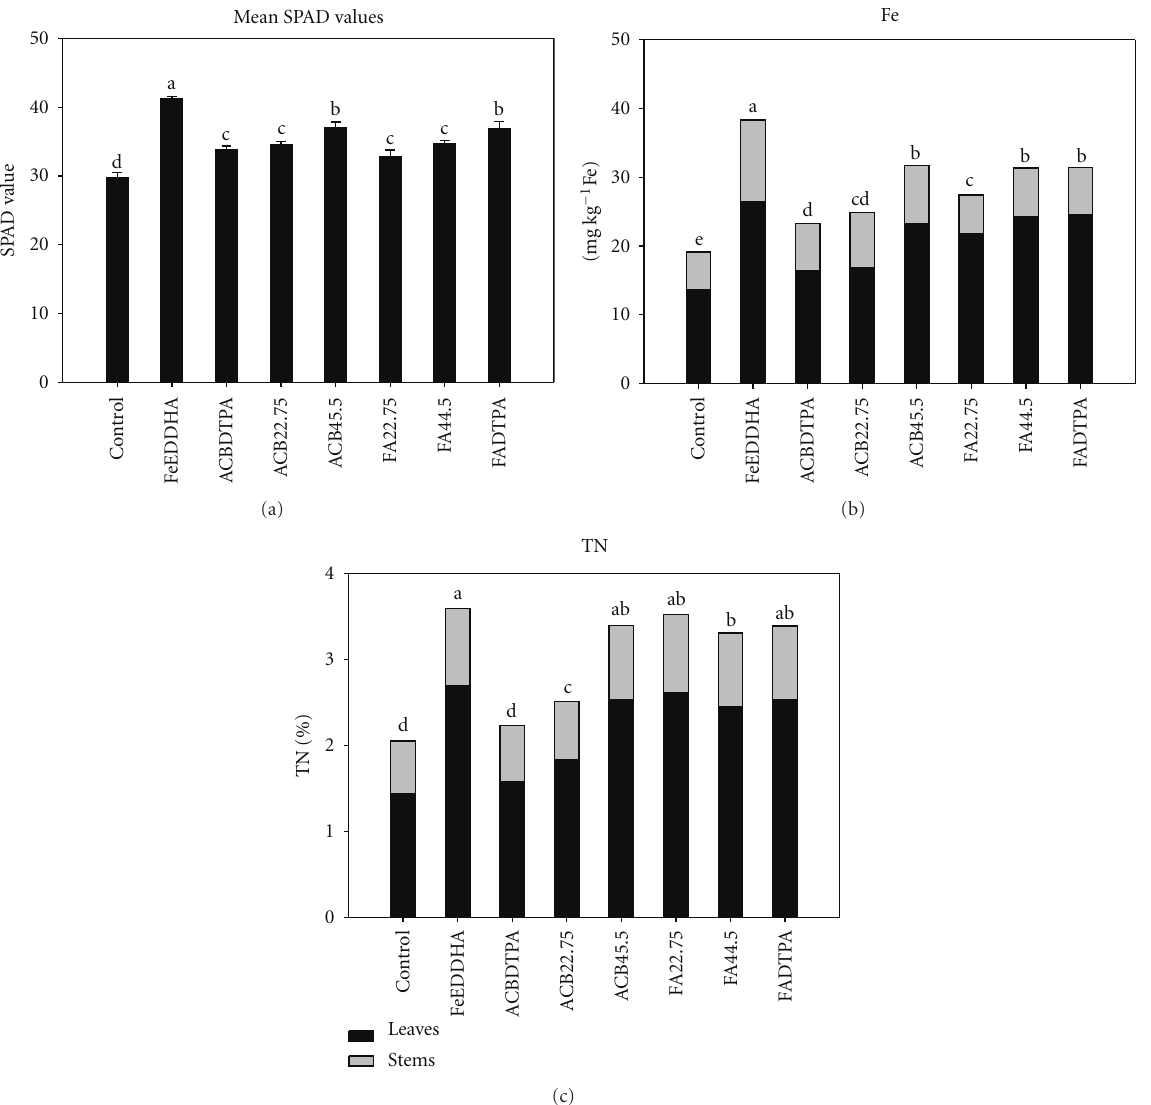
Figure 1: SPAD values (a), plant Fe (b), and total plant N (c) of the hybrid poplar clone OP-367 cultivated in soil amended with Fe EDDHA + UAN (urea ammonium nitrate), fly ash+UAN, and composted biosolids. SPAD means are from two measurement periods. Means with the same letter are not significantly di ff erent at α = 0 . 05 level for combined leaf and stem material. Refer to Experimental Design and Statistical Analysis section for treatment